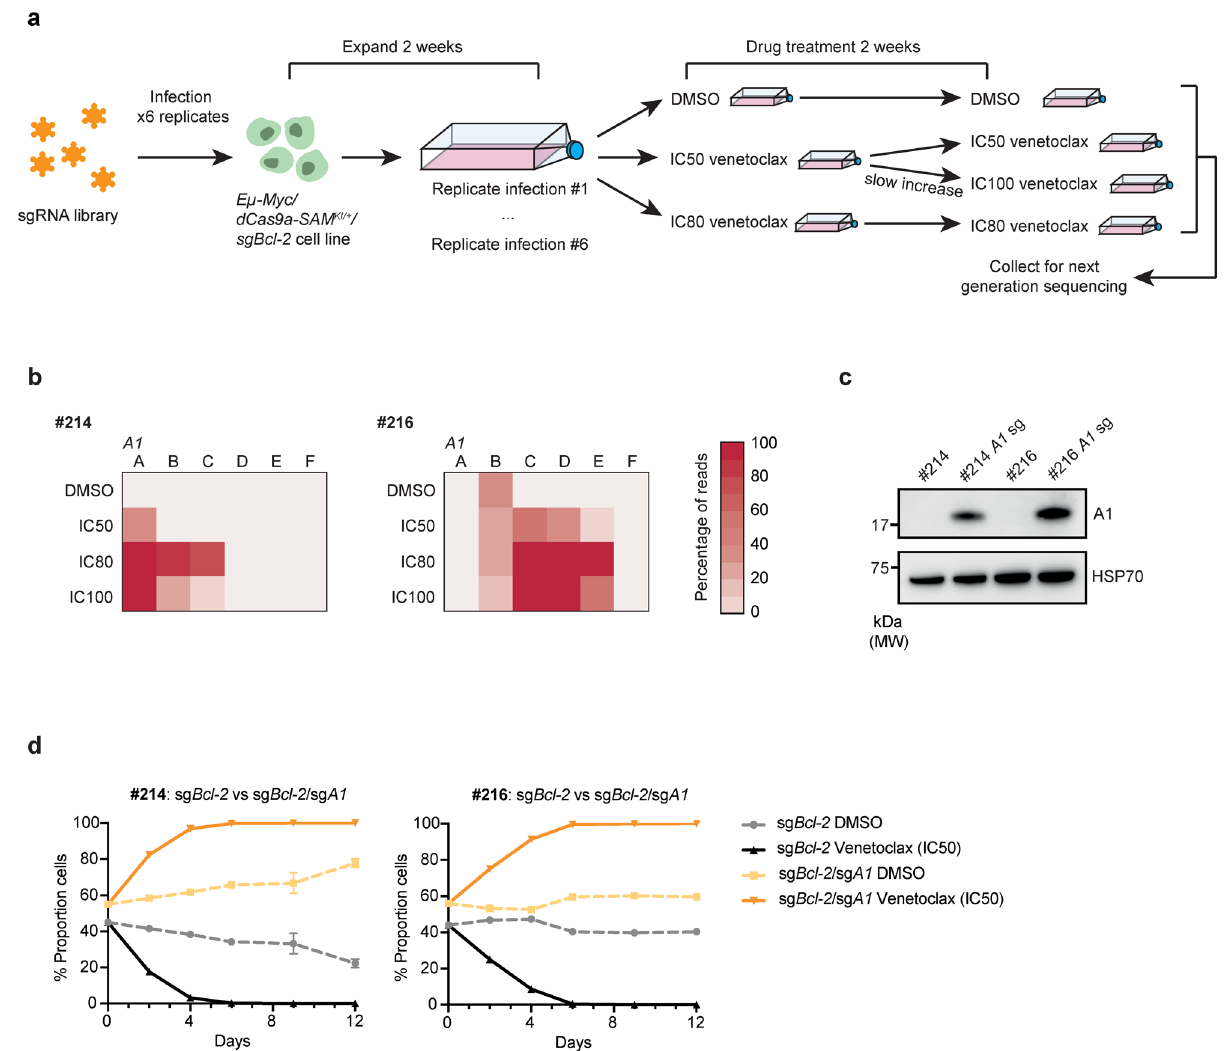
Fig.7|WholegenomeCRISPRactivationscreensinhighMYC/BCL-2expressing lymphoma-derived cell lines reveal upregulation of A1 as a dominant resis- tance factor for venetoclax treatment. a Schematic of whole genome CRISPR activation screens performed in two independently derived murine lymphoma cell lines (#214, #216). Six replicates of sgRNA library-infected cells were cultured for 2 weeks in the presence of vehicle (DMSO; control) or the indicated doses of the BCL-2inhibitorvenetoclaxbeforebeinganalysedbynextgenerationsequencingto identifyenrichedsgRNAs. b Heatmapsshowingtheproportionsofsequencingread resultswhichmappedtosgRNAstargetingthepromoterregionsofthepro-survival gene Bcl2a1(A1) . The six replicate samples for each treatment conditionare shown in columns A-F. c Western blots con fi rming upregulation of A1 protein in DHL-like